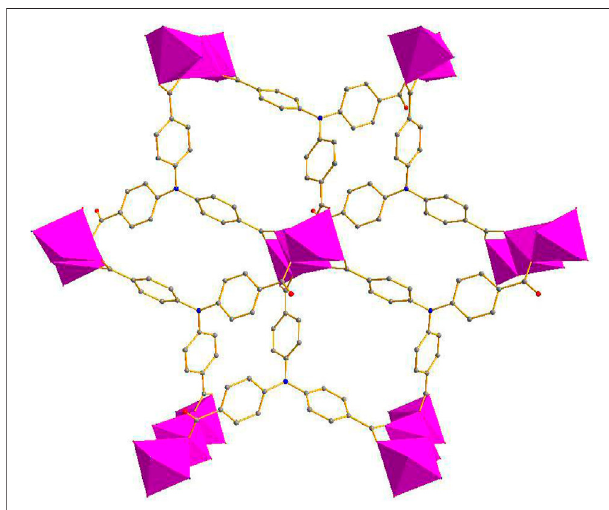
FIGURE 2 | The 2D framework of compound 1 (Co:Purple, O: Red, N: Blue, C: Gray).